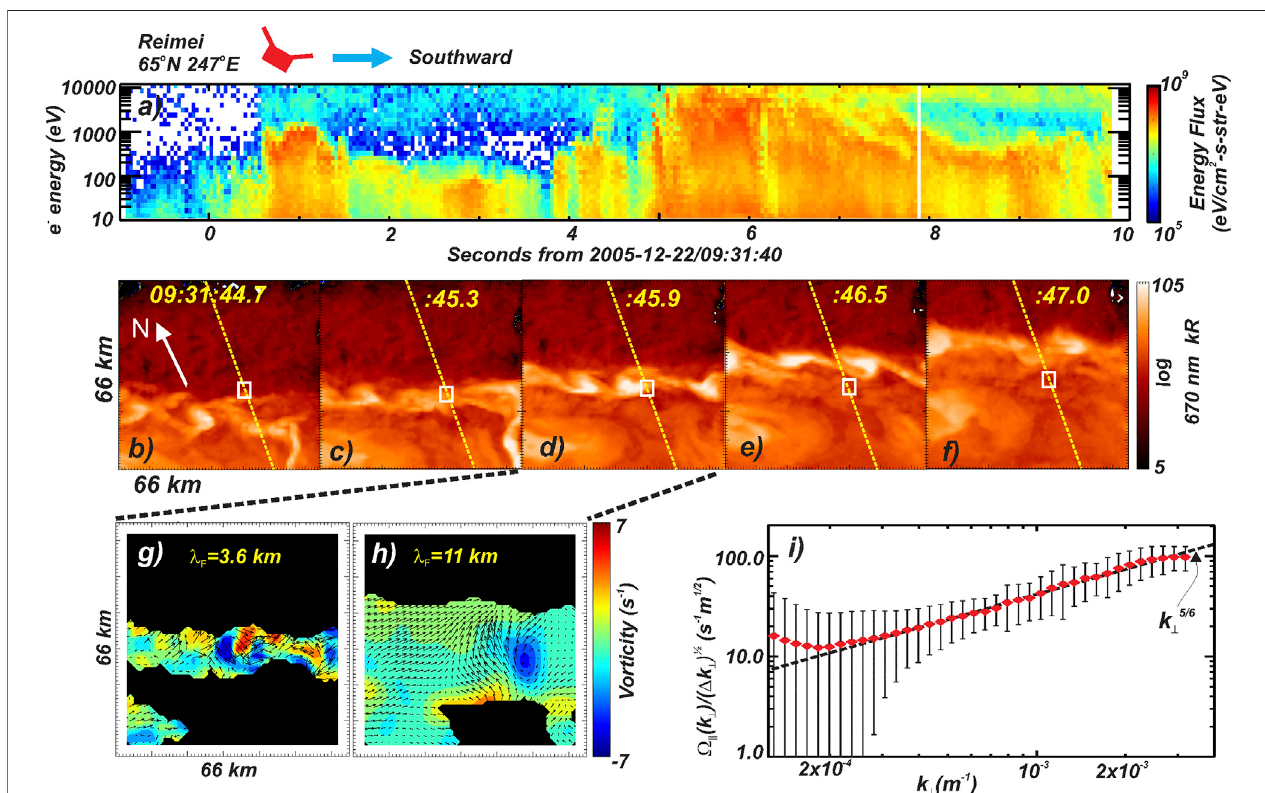
FIGURE 2 | Reimei spacecraft measurements above an “ Alfvenic ” auroral arc. (A) Omni-directional electron energy spectrogram. (B – F) Snapshots at ∼ 670 nm of the evolving luminosity. Yellow trace shows the trajectory ofthe spacecraft mapped onto each image with the white box indicatingthe spacecraft magnetic foot-pointat thesnapshottime. (G – H) Opticalvorticitymeasurementsderivedfromcross-spectralanalysisbetweensnapshotdandthenextframecapture(notshown)atthescales indicated. Arrows show optical fl ow direction and relative speed. (I) Vorticity spectrum derived from the full resolution measurements over the time-range comprising the sequence (B – F) . Red dots show the log normal average in each k ⊥ bin while the error bars show 1 standard